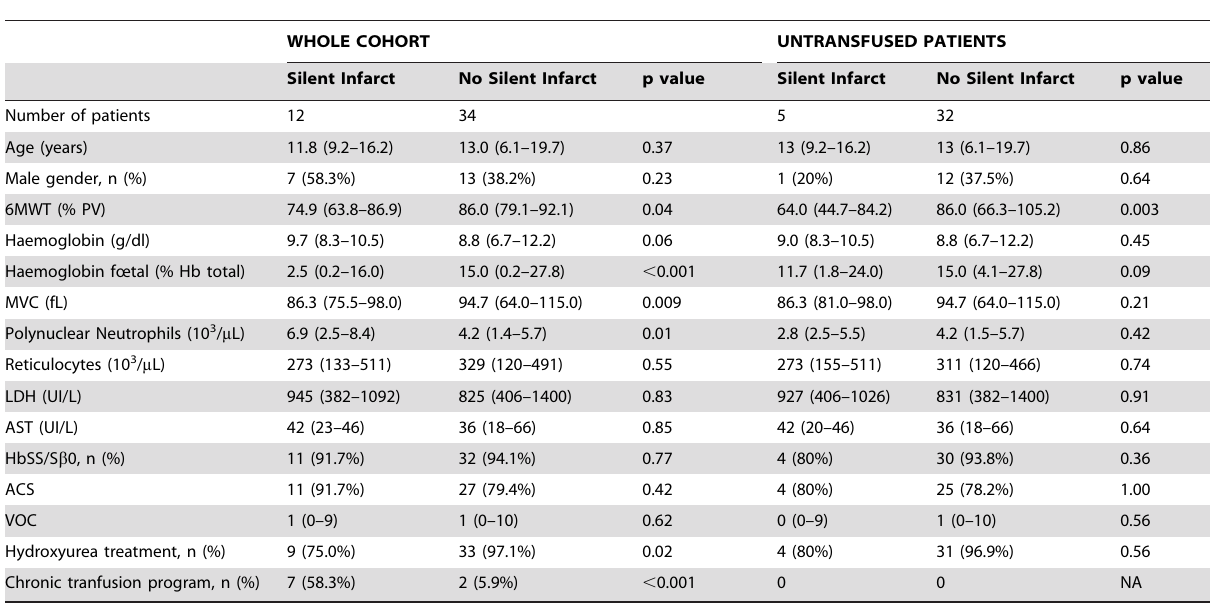
Table 2. 6MWT performance, hematological and clinical factors according to the presence of silent infarct; results are median (range) unless otherwise indicated.